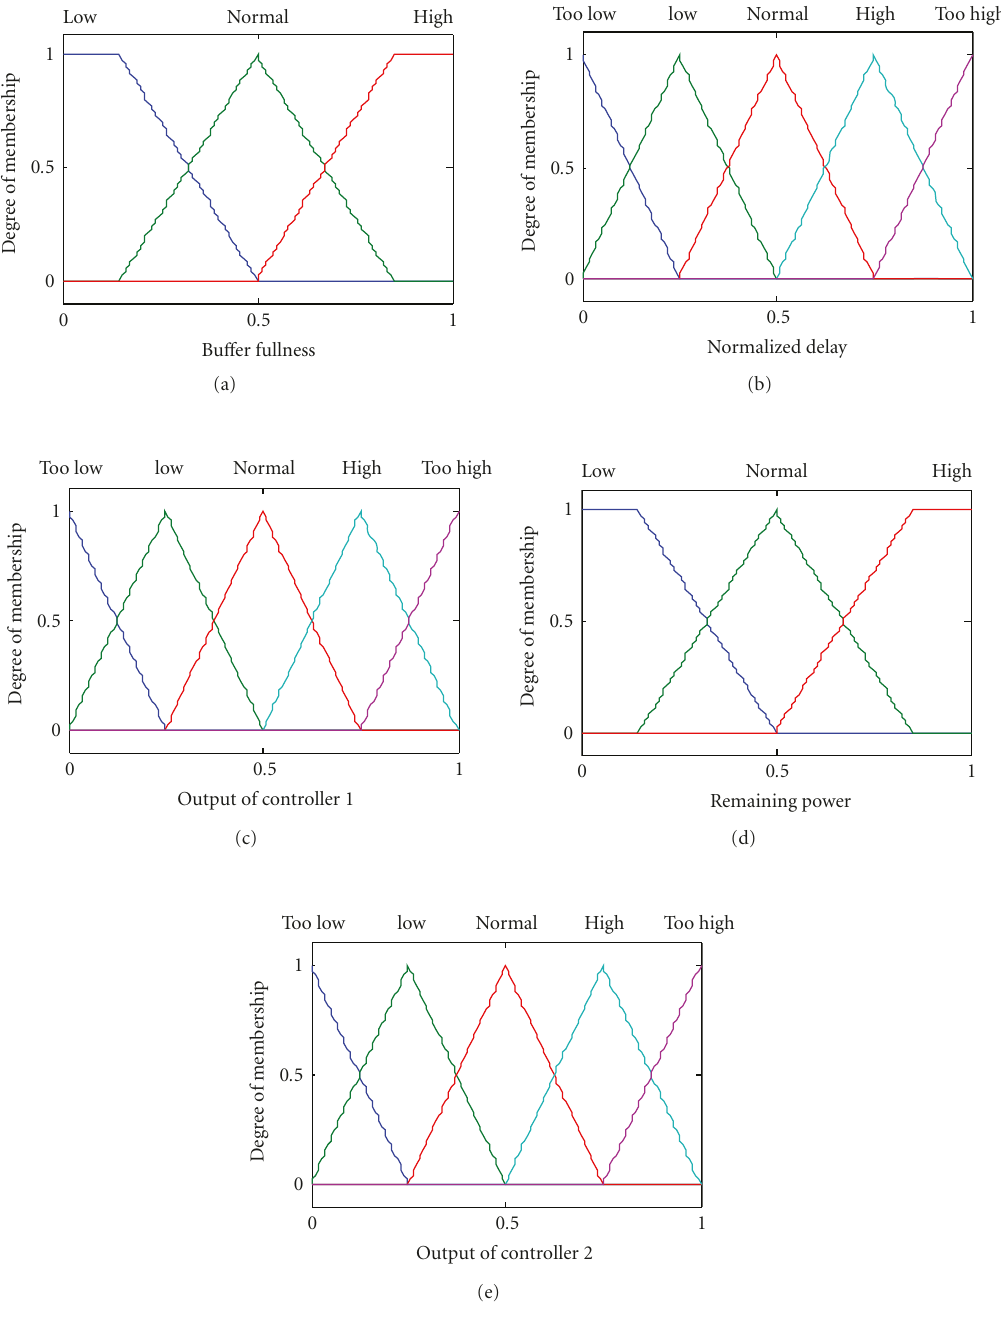
Figure 3: Fuzzy membership functions: (a) stage one, input bu ff er fullness; (b) stage one, input delay deadline; (c) output of stage one controller; (d) stage two input remaining power; (e) stage two output transmission count.